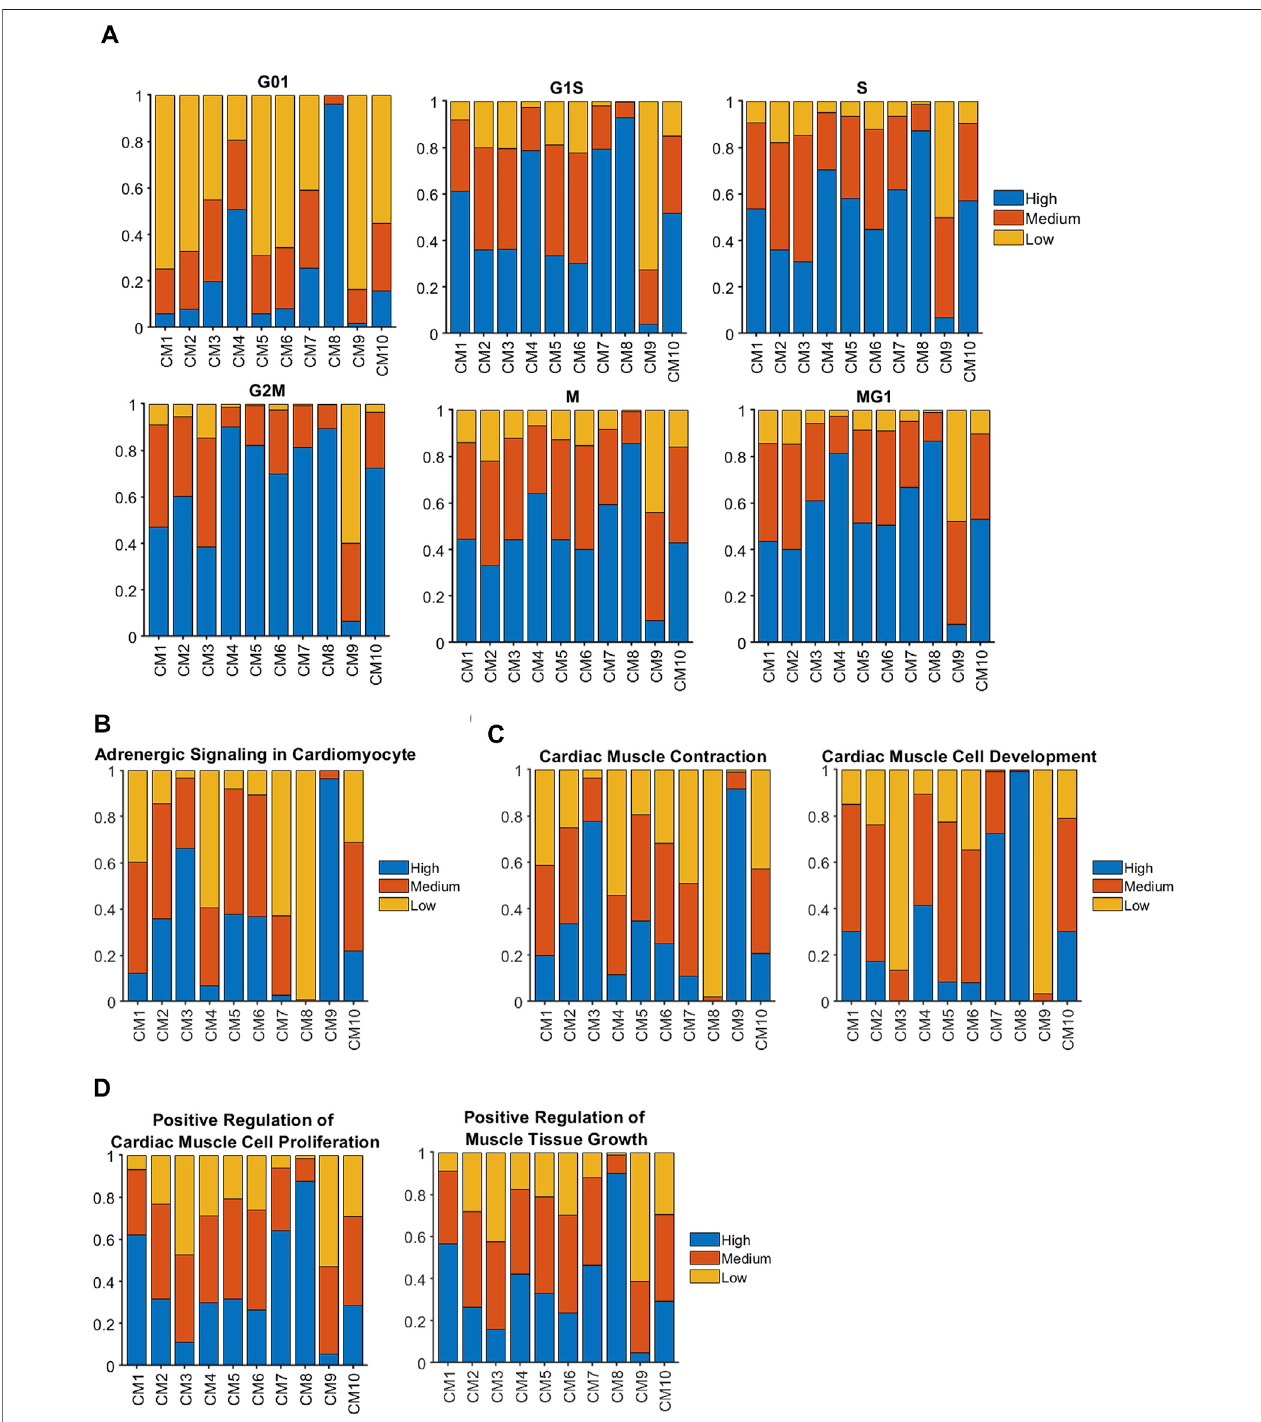
FIGURE2| Genesthatcontributetocell-cycleactivityandmusclegrowthtendedtobemorehighlyexpressed inclustersassociatedwithregeneratingheartsthan in CTL hearts at P28 and afterward. Sparse analysis was conducted for the expression of genes associated with (A) the cell-cycle, (B) adrenergic signaling, (C) the contractileactivity and developmentofcardiac muscle,and (D) cardiac-muscle cellproliferationand muscular growth; then, theproportion ofcardiomyocytes withhigh, medium, or low levels of expression was calculated for each cluster.